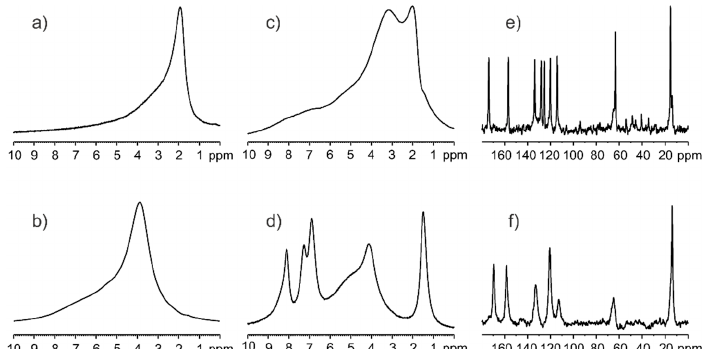
Figure 2. 1 H MAS NMR spectra for ( a ) calcinated silica kept 1h in the oven at 300 °C, ( b ) silica stored in a natural environment without special humidity control, ( c ) mixture of ET/SiO 2(calc) with weight-to-weight ratio 1:3, ( d ) mixture of ET/SiO 2(hydr) with weight-to-weight ratio 1:3 recorded with a spinning rate of 8 kHz. The 13 C CP/MAS ( e ) and 13 C SPE/MAS spectrum ( f ) for ET/SiO 2(hydr ) sample were recorded with a spinning rate of 12 kHz.